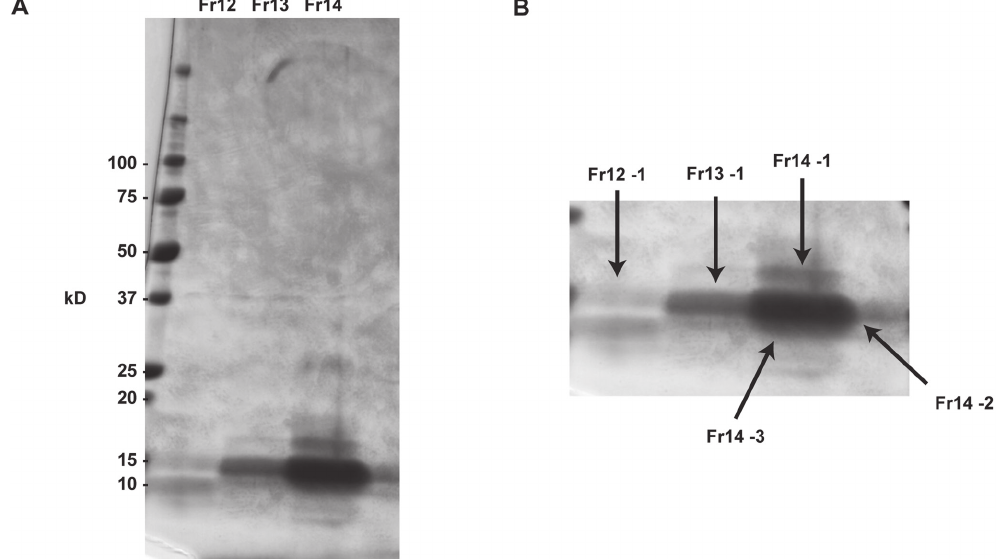
Figure 2- Proteome analysis of bioactive enamel matrix derivative (EMD) fractions. (A) Separation of proteins in bioactive EMD fractions and visualization of protein bands by silver staining. The vertical axis represents molecular mass (kDa); (B)